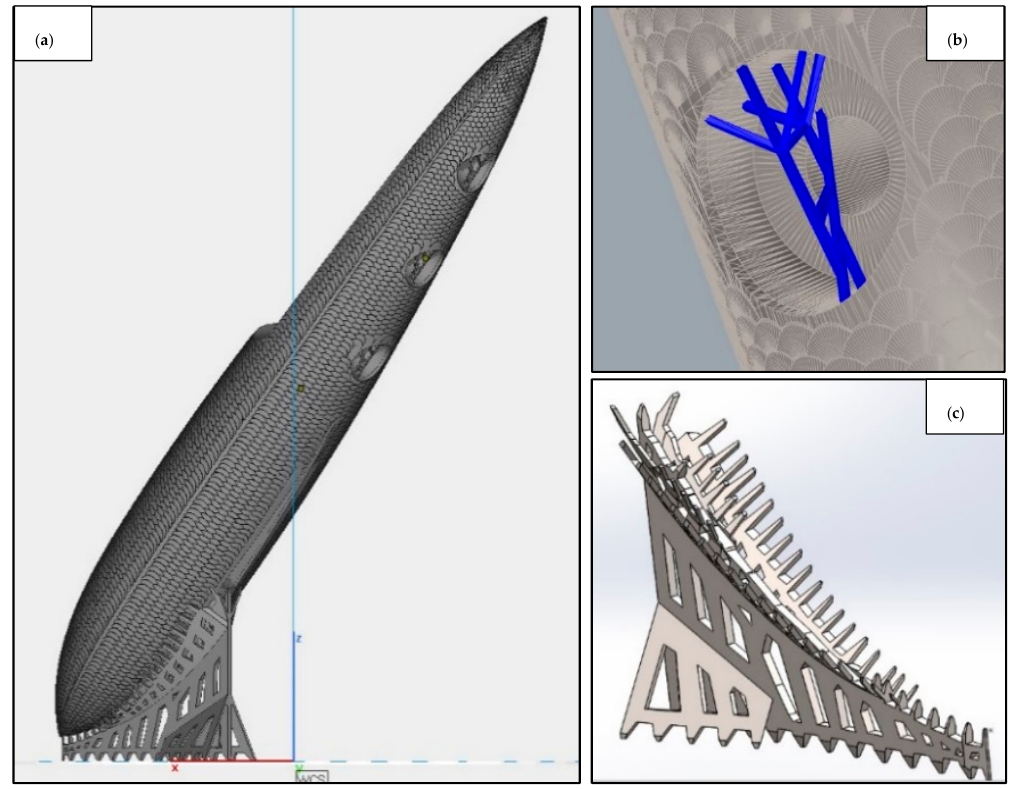
Figure A7. ( a ) Oriented and supported scales-equipped bulb model, ( b ) detail on bolted connection holes support structures and ( c ) isolated main support structure geometry. The overall longitudinal length of the component is 290 mm .